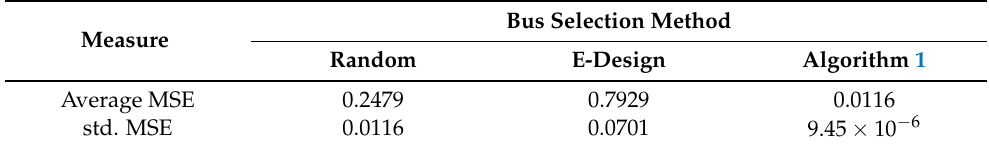
Table 2. State estimation based on the DC-PF model: the average MSE and its standard deviation (std.) for the GSP-WLS (26) and (27) over different values of µ ∈ [ 0.01,1 ] , for q = 48 and σ 2 = 0.01. Bus Selection Method Measure Random